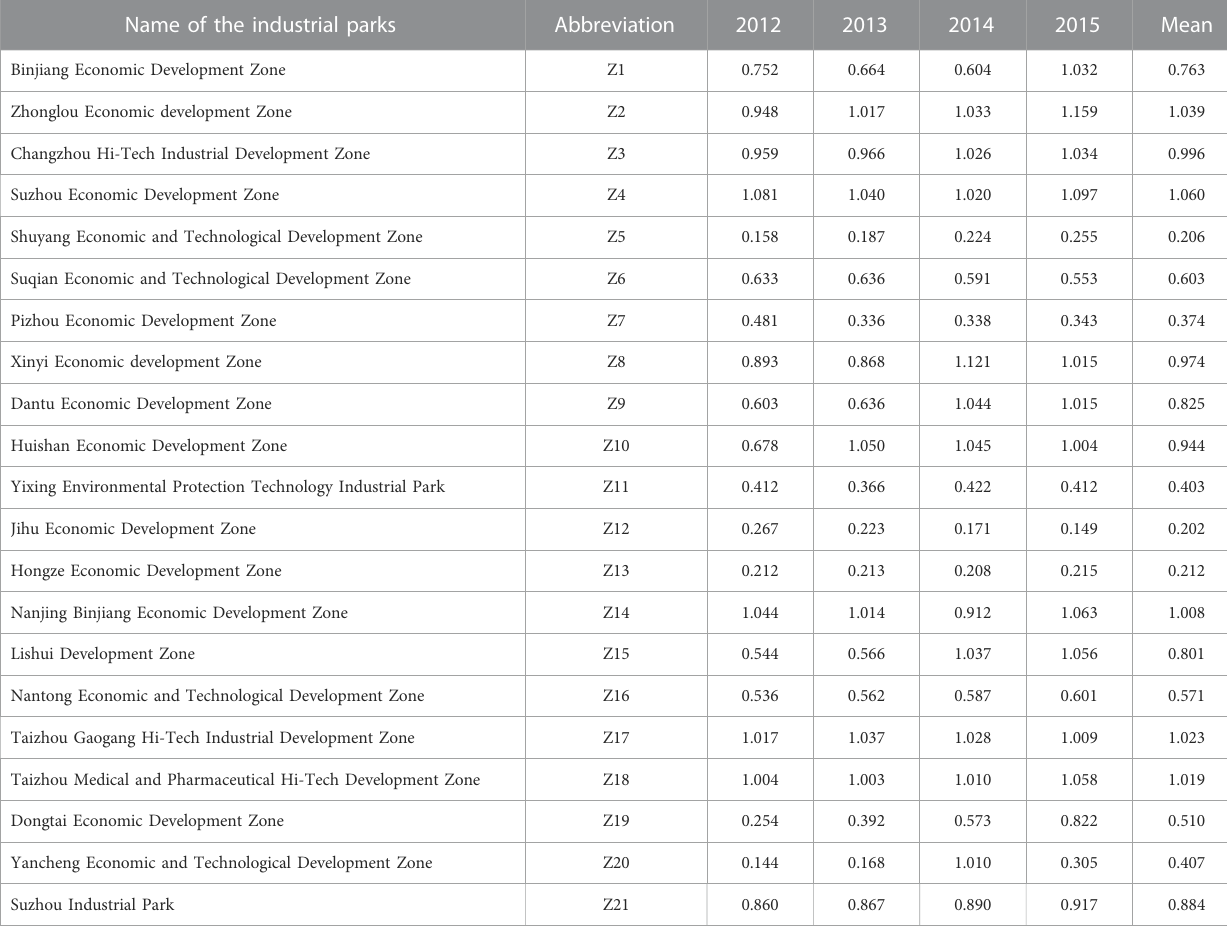
TABLE 1 Eco-ef fi ciency of the demonstration pilot industrial parks (2012 – 2015). Name of the industrial